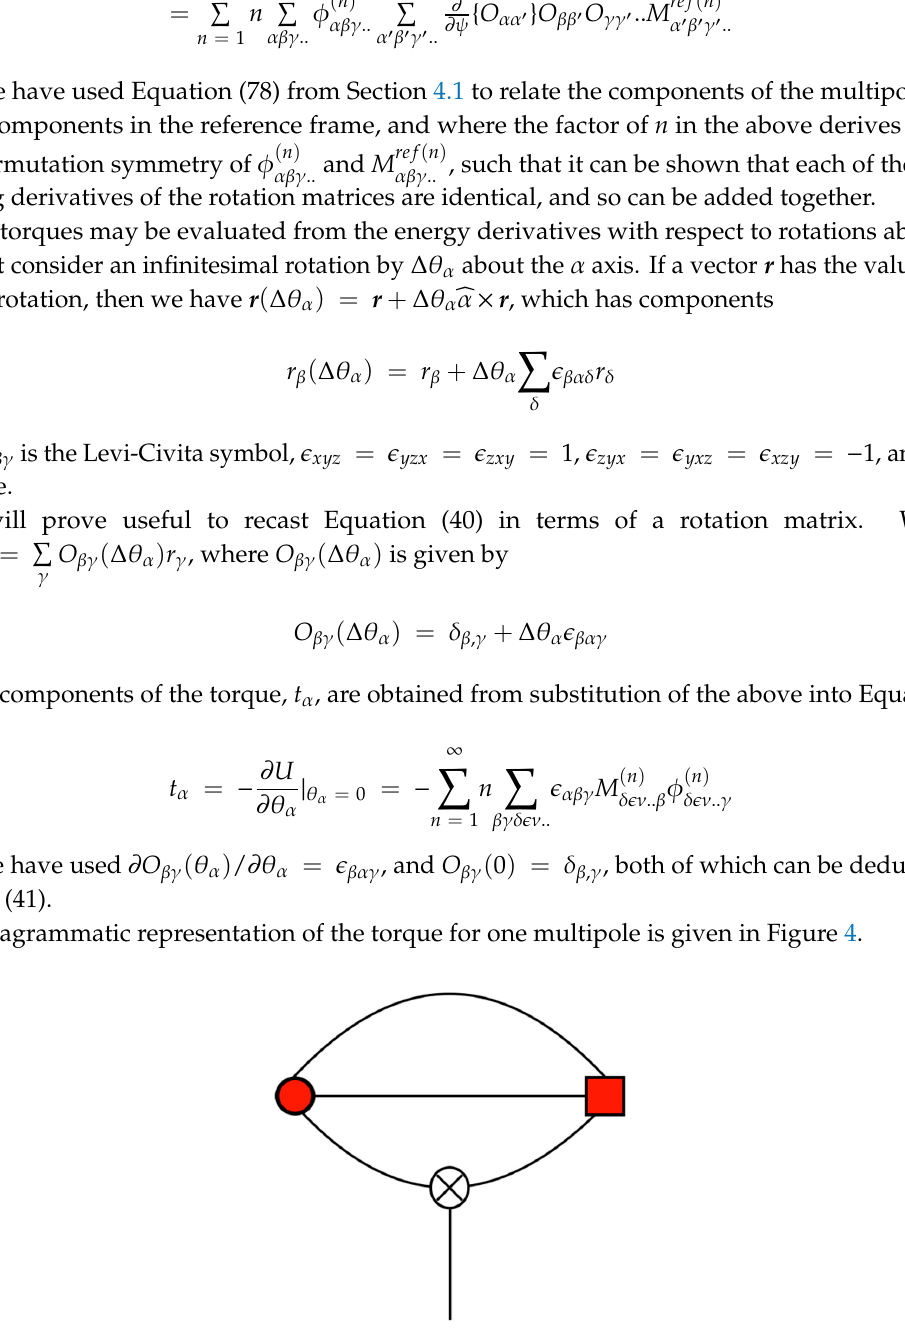
Figure 4. The (negative of) the torque on a rank-3 multipole. The red circle represents the multipole, the red square is its rank-3 field, and the circle with the cross represents a rank-1 vector cross product.